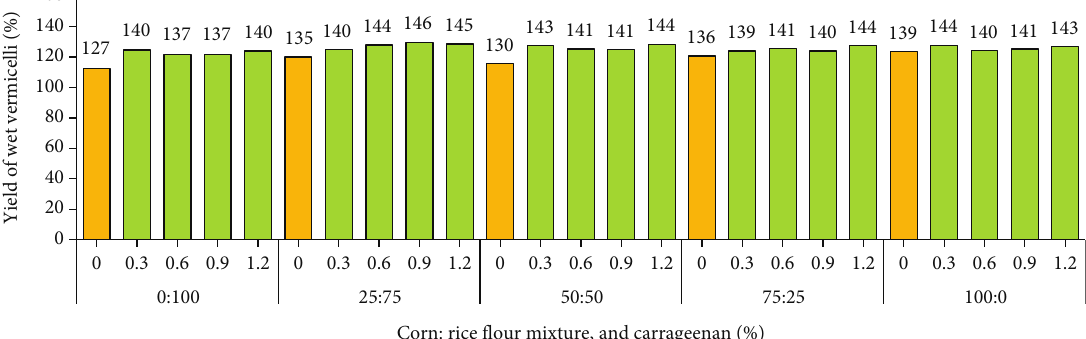
Figure 5: Yield of wet vermicelli (%) (average content of 40.96%). Note: 0: 100 (0% corn: 100% rice); 25:75 (25% corn: 75% rice); 50:50 (50% corn: 50% rice); 75 :25 (75% corn: 25% rice); and 100 :0 (100% corn: 0% rice). Carrageenan: 0, 0.3, 0.6, 0.9, and